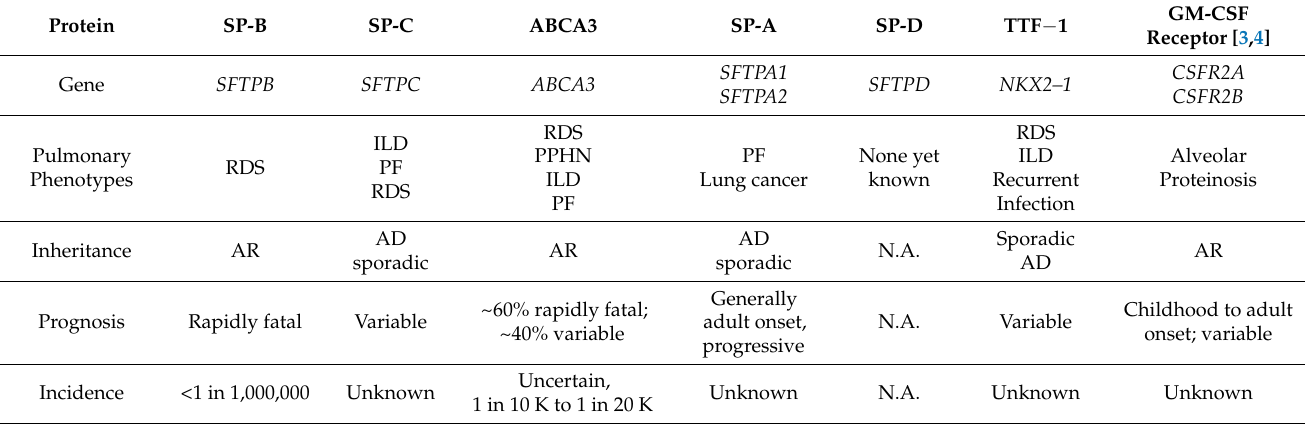
Table 1. Genetic surfactant related